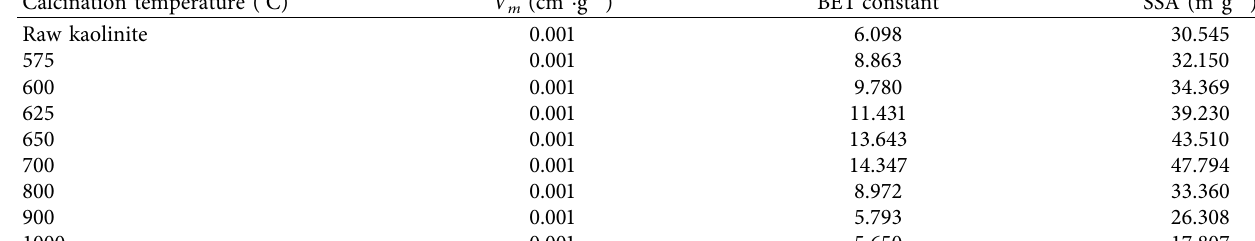
Figure 1: Effect of calcination temperature on the pozzolanic activity of Ethiopian kaolinite. Table 1: The specific surface area (SSA) of the kaolinite samples at various calcination temperature. Calcination temperature ( °